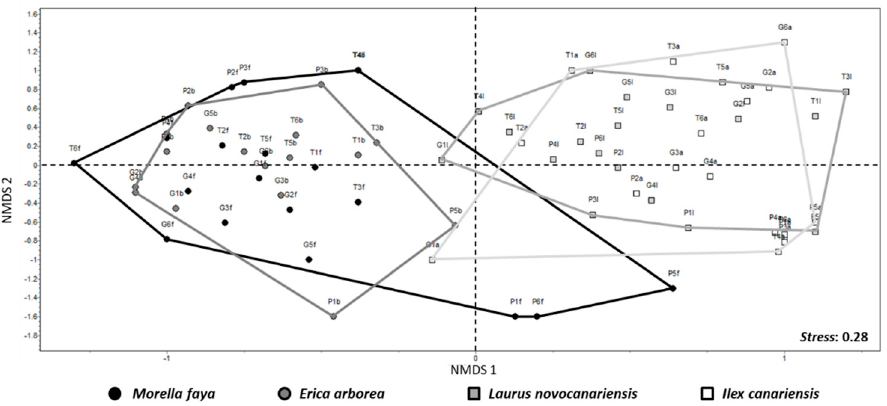
Figure 6. NMDS plot based on abundances matrix and Jaccard distances. Each point represents the sum of lichen abundance in the two trees sampled of each different phorophyte in each plot. Stress : 0.28.